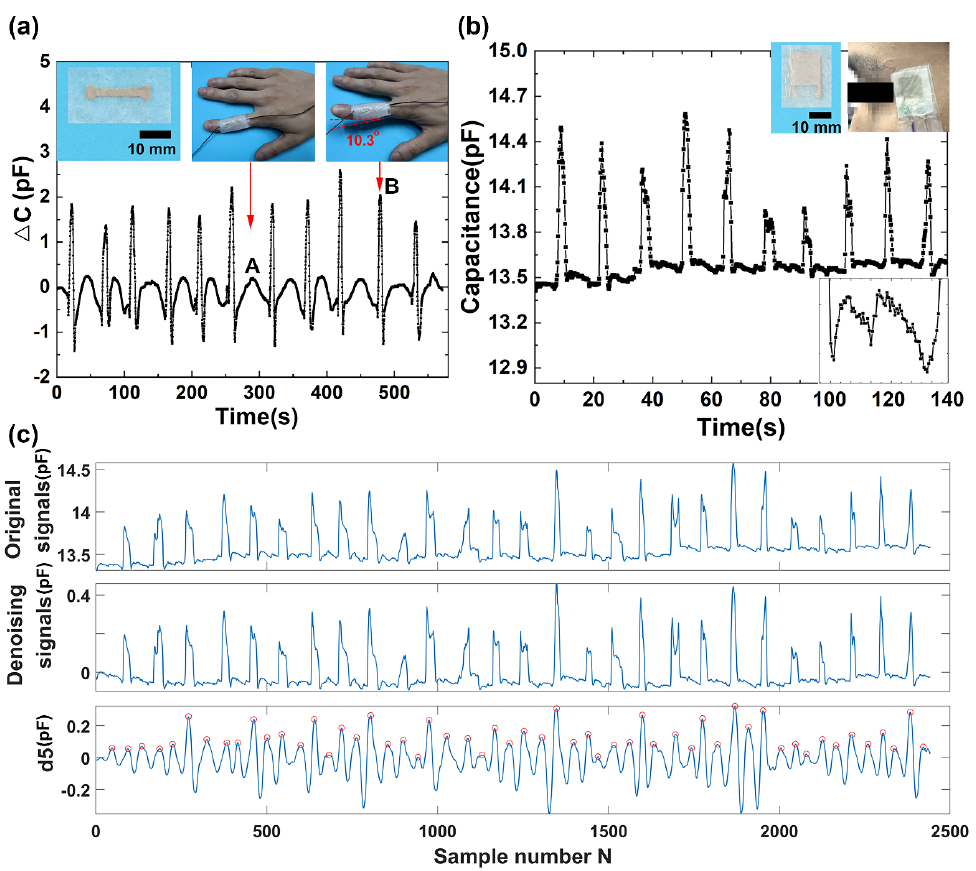
Figure 4. Capacitive sensor for detection of finger motion and eye blinking. ( a ) Capacitance profile of finger motion. ( b ) Capacitance profile of eye blinking. ( c ) The 5th level wavelet high-frequency coefficient decomposed from the original eye blinking signal (d5).